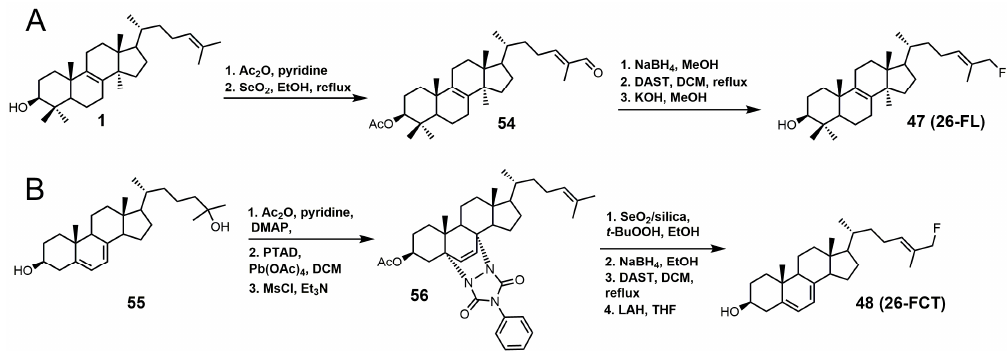
Figure 28. ( A ) Synthesis of 26-fluorolanosterol (26-FL) ( 47 ); ( B ) synthesis of 26-fluorocholesta-5,7,24-trienol (26-FCT) ( 48 ).